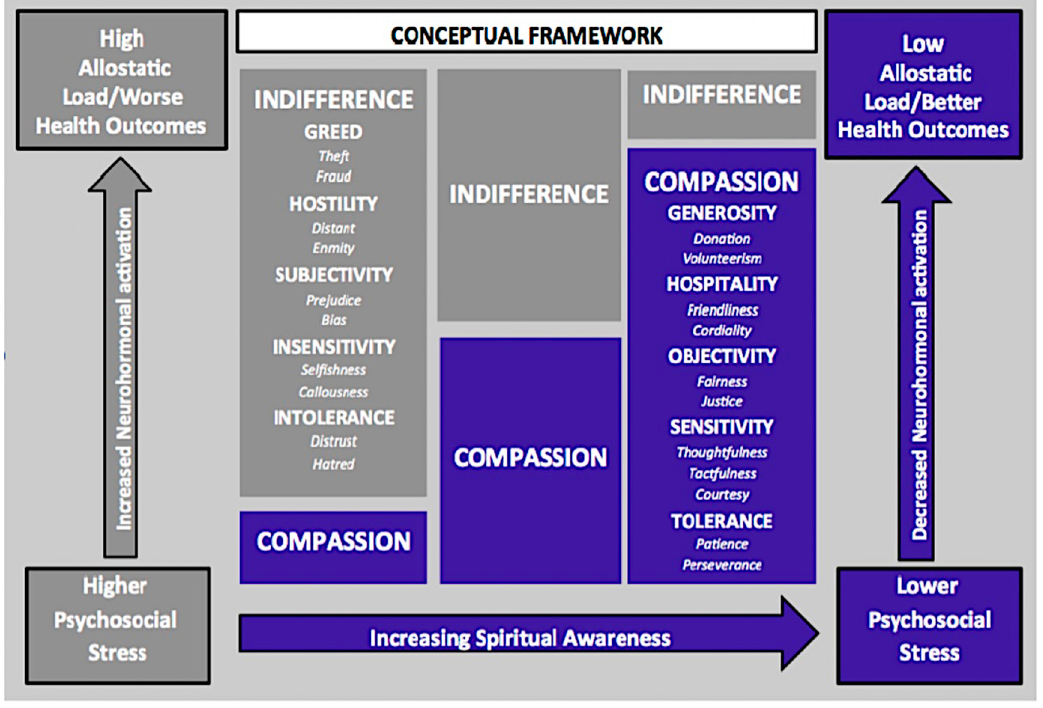
Figure 1. Legend. A proposed framework by which increasing spiritual awareness may reduce psychosocial stress and allostatic load to improve health outcomes.